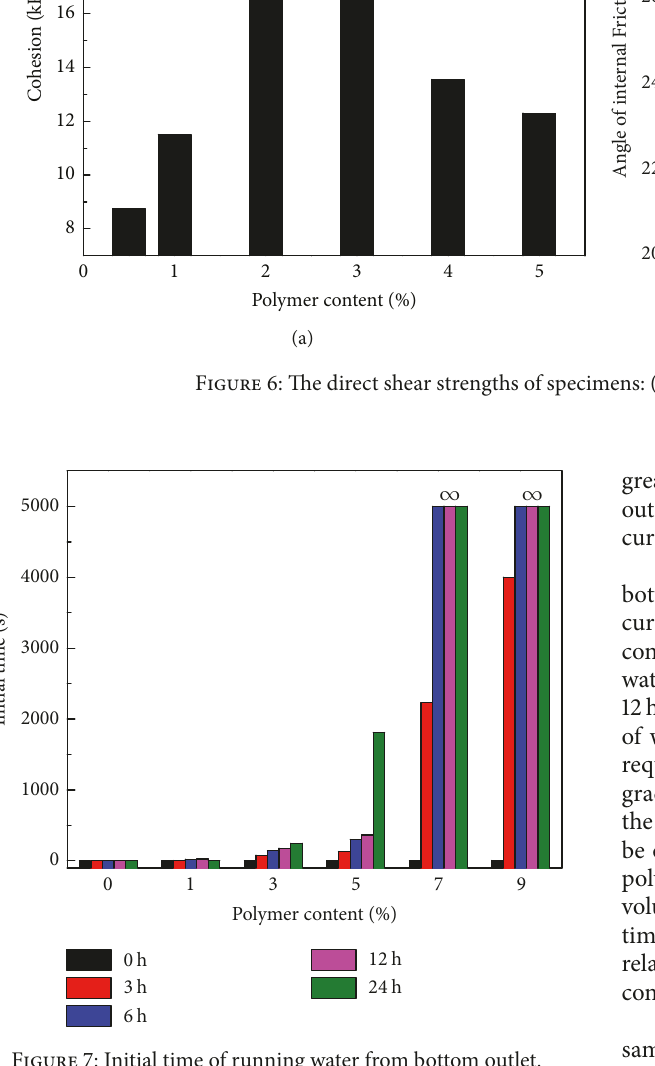
the sample at every three minutes with a number of 5 times was also